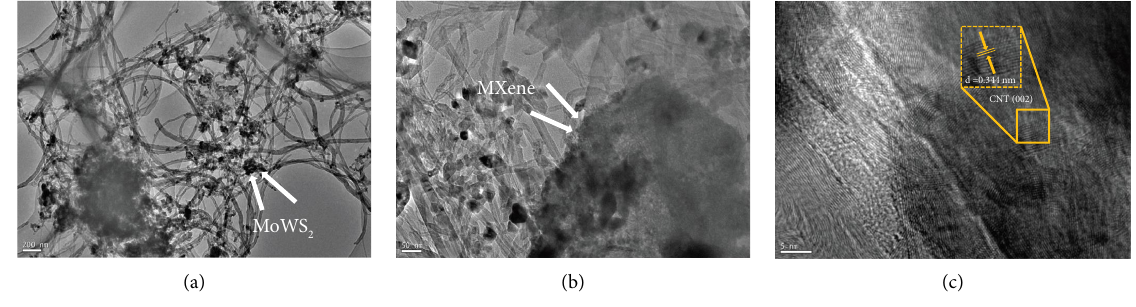
Figure 4: (a) and (b) TEM and (c) HRTEM images of MoWS